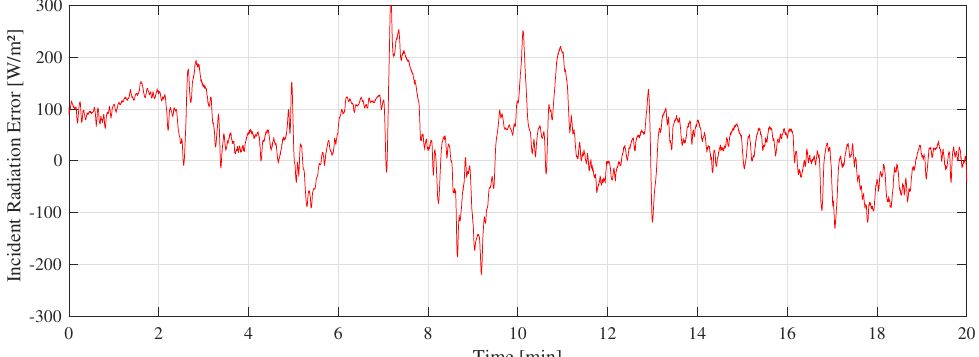
Figure 18. Difference between SR-05 and CTD prototype in C measurement.